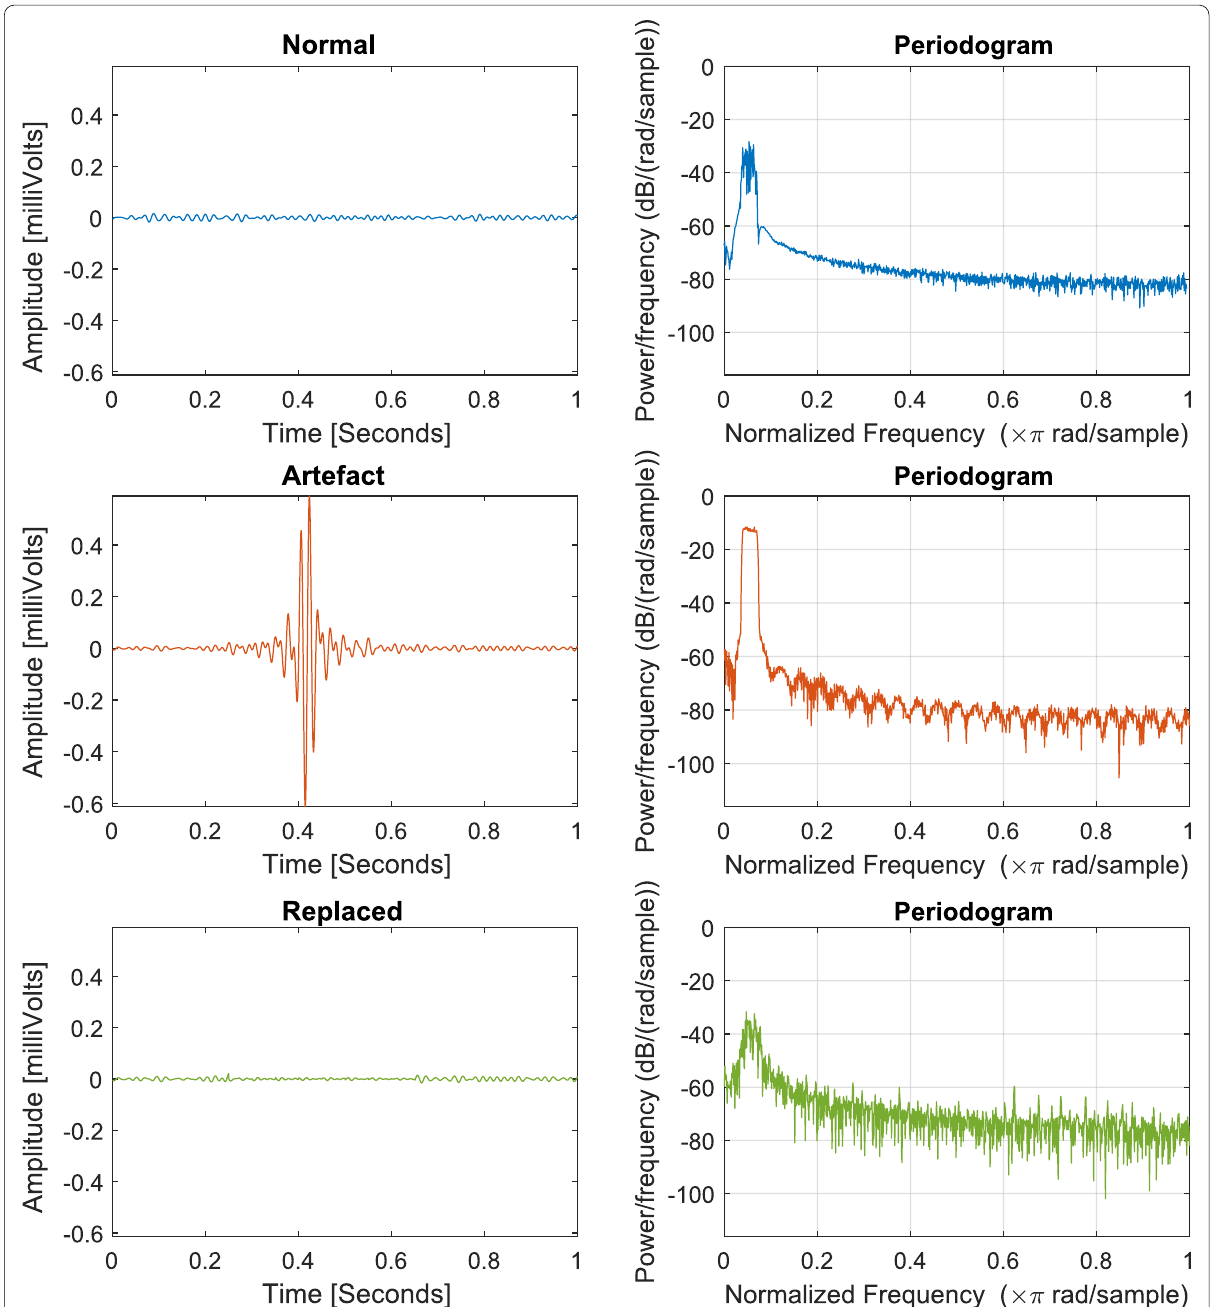
Fig. 6 Examples of normal (blue), artefactual (red) and replaced-segments signals (green) alongside their periodograms for data set 1. The method has been able to recreate the normal signal, both in amplitude as in spectral